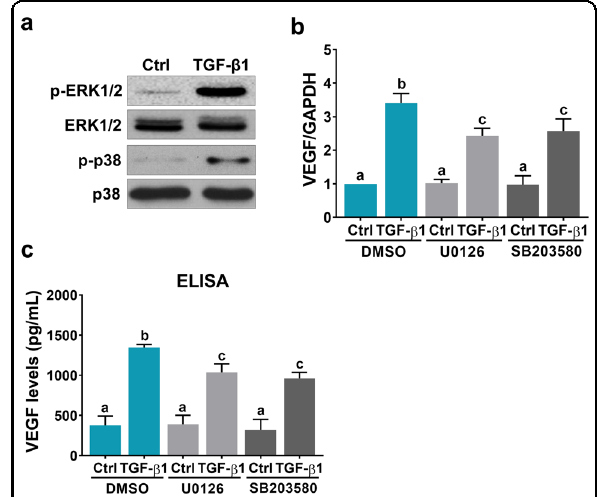
Fig. 5 ERK1/2 and p38 MAPK signaling pathways are involved in TGF- β 1-induced VEGF expression and secretion. a SVOG cells were treated with 5 ng/mL TGF- β 1 for 10 min. Phosphorylated and total ERK1/2 and p38 expression levels were determined by western blot. b SVOG cells were pretreated with a vehicle control (DMSO), 10 µM U0126 or 10 µM SB203580 for 1 h, and then they were treated with 5 ng/mL TGF- β 1 for 6 h. VEGF mRNA levels were examined by RT- qPCR. c SVOG cells were pretreated with a vehicle control (DMSO), 10 µM U0126 or 10 µM SB203580 for 1 h, and then they were treated with 5 ng/mL TGF- β 1 for 24 h. VEGF protein levels in culture media were examined by ELISA. The results are expressed as the mean ± SEM of at least three independent experiments. The values without a common letter are signi fi cantly different ( p <